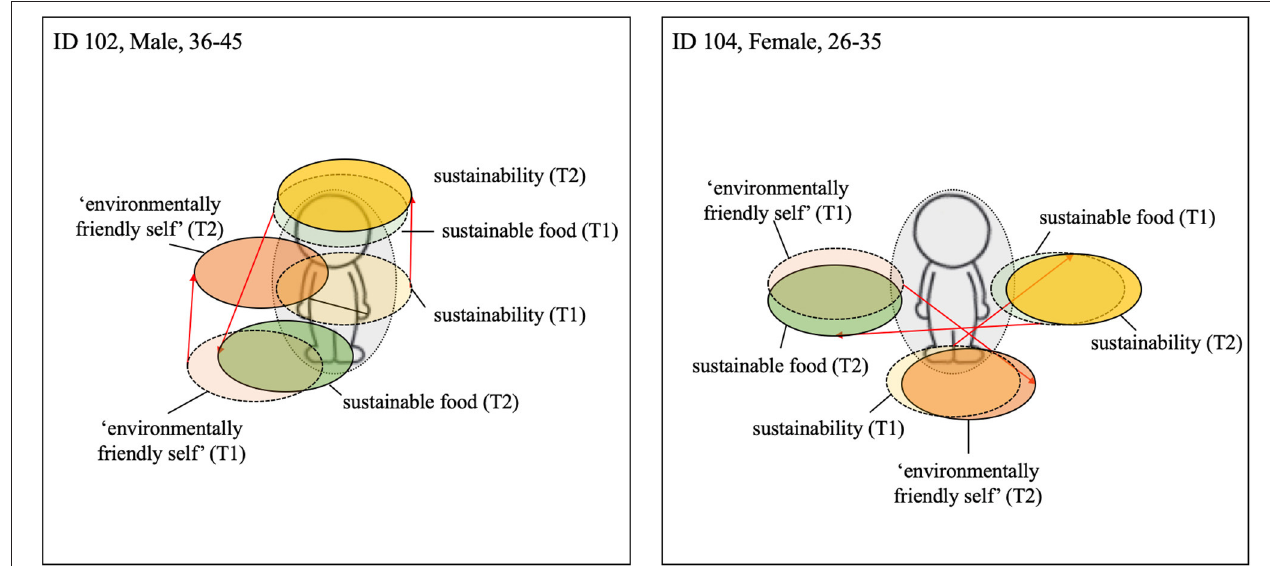
FIGURE 6 | Visualization of centrality of identity—Increased awareness and concern; Dashed line = T1; solid line and darker coloring = T2; Red arrow indicates change from T1 to T2 (the colors were added after the analysis).